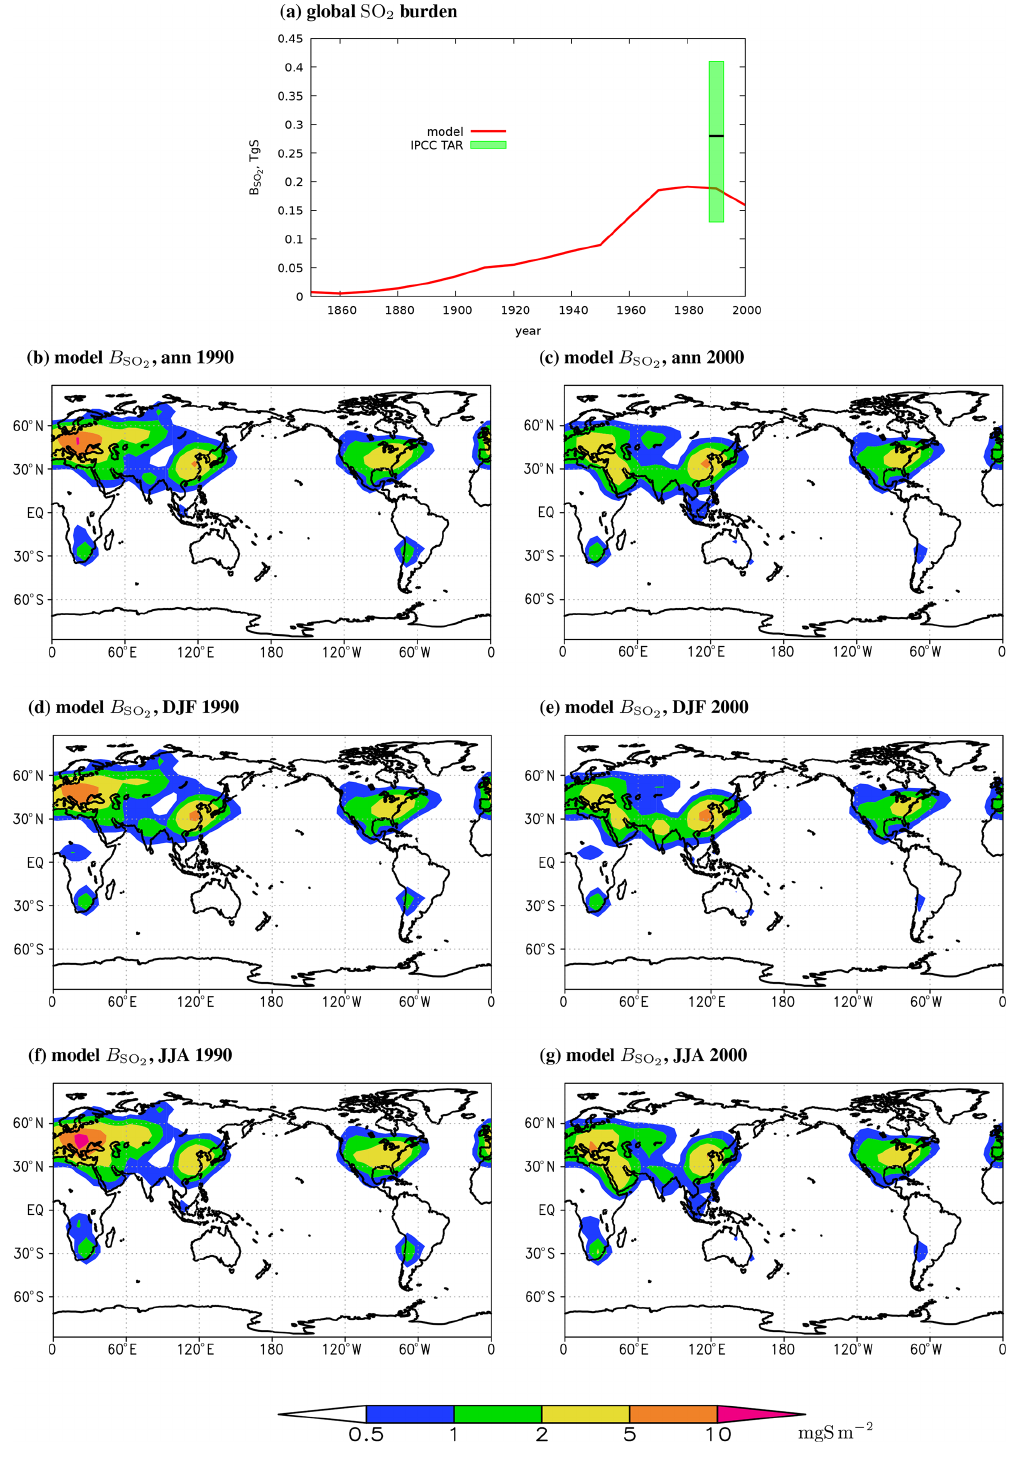
Figure 3. The globally and annually averaged modelled SO 2 mass in the atmosphere (a) and the respective annual mean (b, c) , December– February mean (d, e) , and June–August mean (f, g) burdens per unit area in 1990 (b, d, f) and 2000 (c, e, g) . The green box shows the respective emission-rescaled IPCC TAR Table 5.5 estimate (see the caption of Table 2) and its